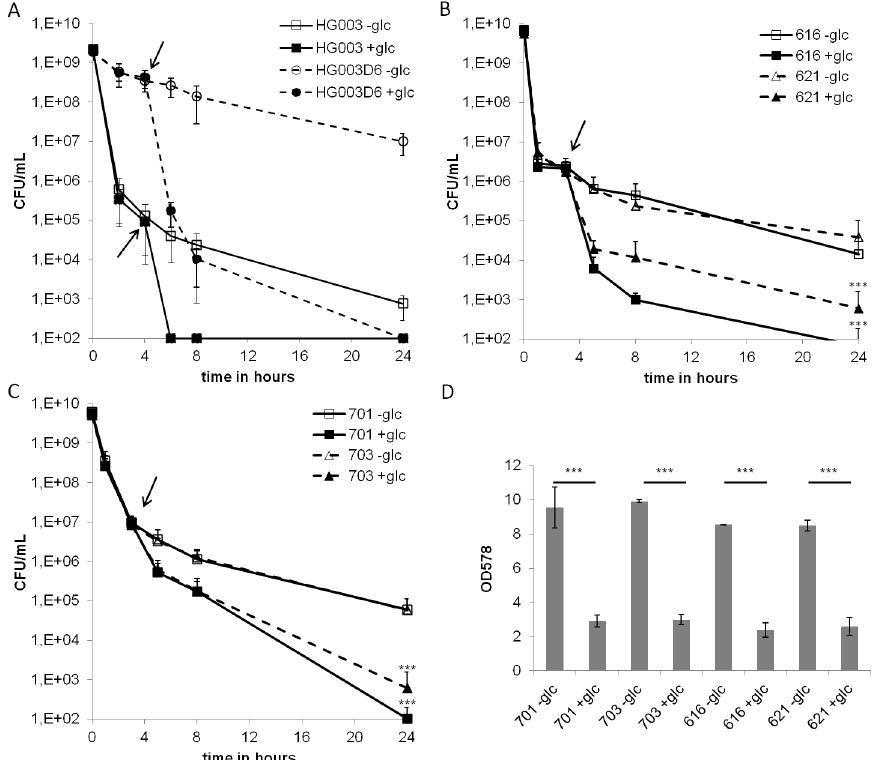
Fig 5. Time-dependent killing of strains with different susceptibilities towards DAP. Stationary phase cultures of HG003, HG003 D6 and the clinical S . aureus strains 616, 621, 701 and 703 were treated with 100-fold, or 250-fold the MIC of DAP, respectively. At t = 3h, glucose was added (arrow) to the cultures (filled symbols) and CFU values were determined over time. For statistical analysis endpoint ODs after 24 hours for -Glc and +Glc for each strain were compared with unpaired t-test (with Welch ’ s correction for unequal variances if appropriate) *** p < 0.001. A) Growth-phase-dependent DAP-tolerant strain HG003 D6 (square) and parent wild type strain HG003 (triangle). B) DAP-tolerant strains 701 (square) and 703 (triangle) (MIC = 2 mg/L). C) Sensitive strains 616 (square) and 621 (triangle) (MIC = 0.5 mg/L). D ) Optical densities after 24h of incubation. Strains were challenged with 100-fold the MIC of DAP from t = 0h. Identically treated cultures were supplemented with glucose from t =